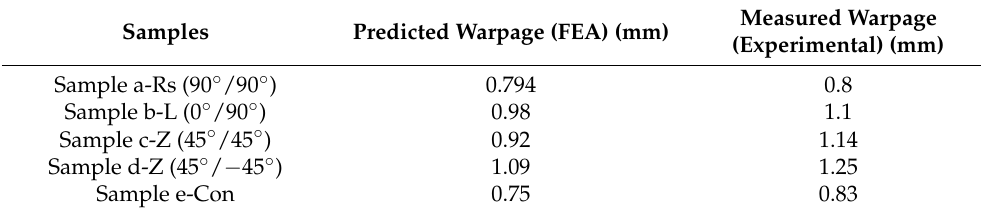
Table 3. Comparison of warpage values from element m of various raster pattern samples that were simulated and